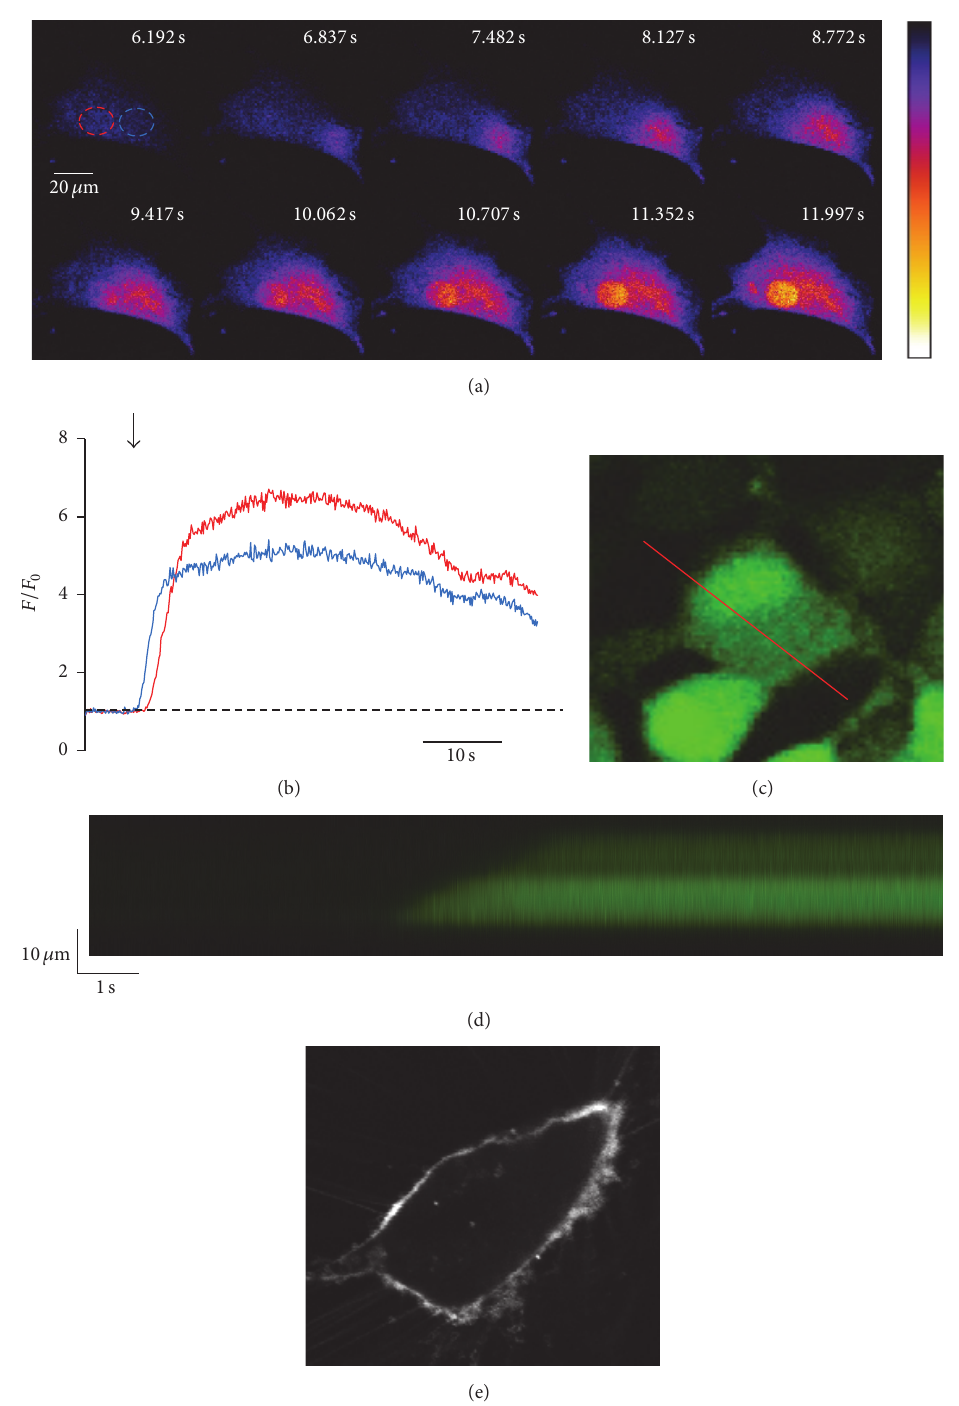
Figure 3: Ca 2+ oscillations in electrically stimulated CPCs show spatial heterogeneity and propagate in a wave-like fashion. ((a) and (b)) Representative 2D high-speed confocal image montage of the activation of a Ca 2+ oscillation in a CPC loaded with fluo-4/AM. ROIs (red: nuclear, blue: cytosolic) indicated in (a) are graphed in (b). ((c) and (d)) Measured from the red line shown in (c), the confocal line scan in (d) shows that initiation of Ca 2+ release at one edge of the cell propagates through the cell to the other side. (e) Representative image of a CPC stained with